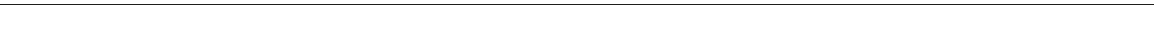
Fig. 8 Nuclear exclusion is necessary to enforce AID licensing. a (Left) Representative confocal microscopic images of AID-GFP and AID Δ E5-GFP fusions in CH12 B cells. (Right) Nuclear GFP signal was measured as the overall GFP signal overlapping with a nuclear mask, generated using Dapi signal. Cells expressing each construct were fi xed and imaged with identical settings in parallel. Individual cell values (dots) are plotted relative to the median of AID- GFP, from one experiment. Control shows untransfected cells signals. Differences were evaluated by unpaired, two tailed t -test. b Relative mutagenic activity of AID Δ E5 variants in E. coli , measured as the frequency of rifampicin-resistant (Rif-R) colony-forming units (cfu). Means (bars) of medians